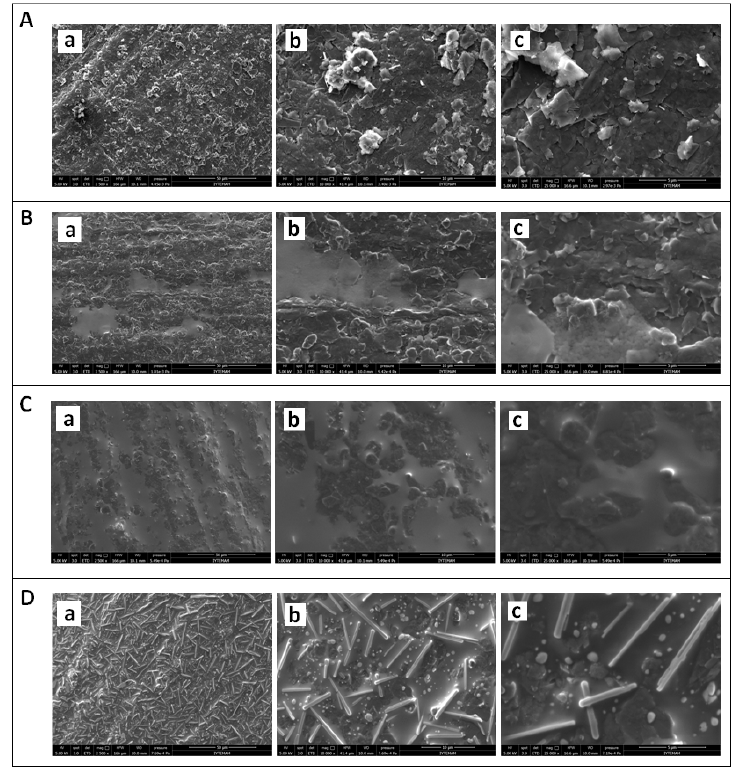
Figure 4. SEM images of ( A ) unmodified PGE, ( B ) CA modified PGE, ( C ) IL modified PGE, ( D ) CA and IL modified PGE using identical acceleration voltage as 5.0 kV with resolution at ( a ) 50 µm, ( b ) 10 µm and ( c ) 5 µm respectively.